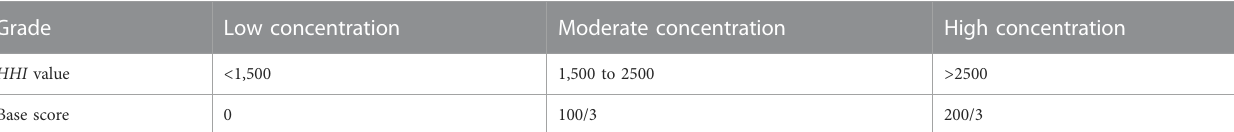
TABLE 2 HHI classi fi